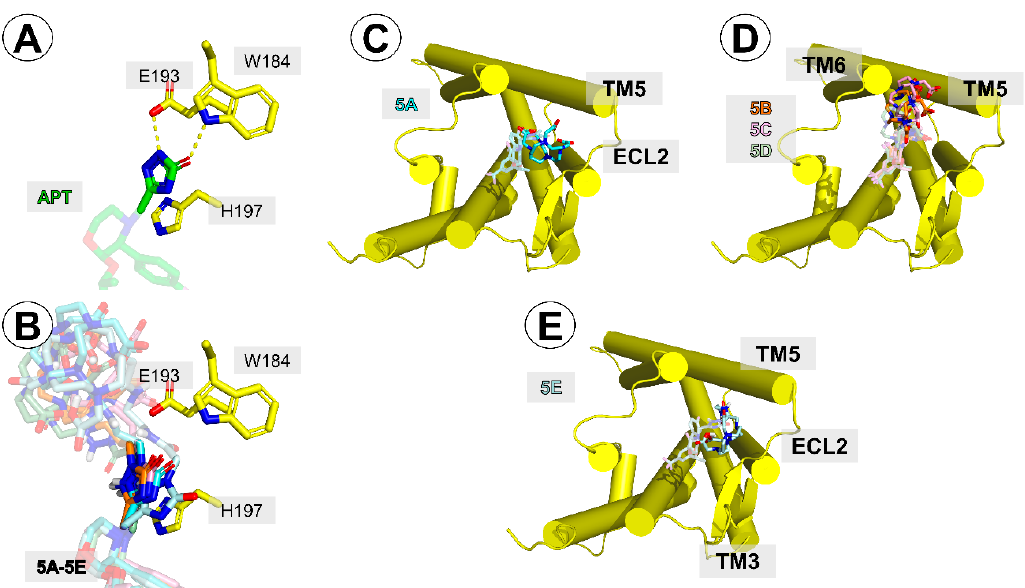
Figure 6. ( A ) Interactions of aprepitant’s triazolinone ring with W184, E193, and H197 side ‐ chains. ( B ) positioning of the triazolinone ring of the conjugates in the same projection as in ( A ). ( C – E ) Relative position of the DOTA moiety in conjugates 5A ( C ), 5B – D ( D ), and 5E ( E ). The receptor helices are shown as yellow cylinders.